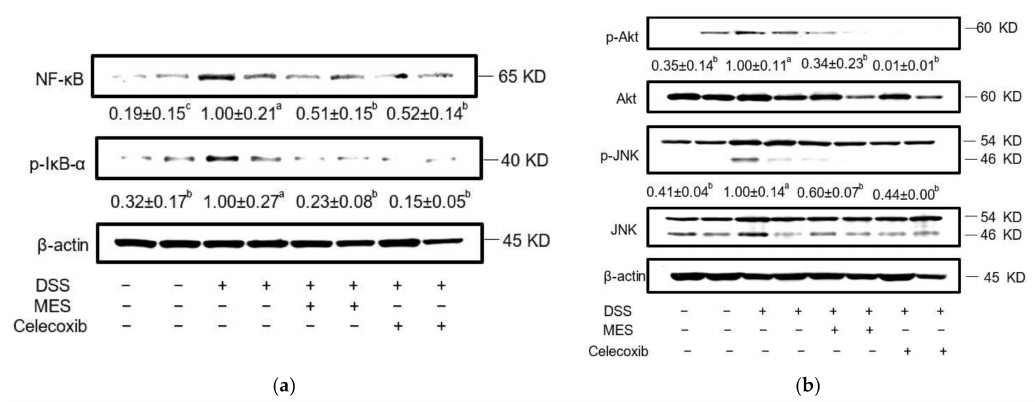
Figure 6. MES administration inhibits NF- κ B, Akt and JNK signal pathways in DSS-induced colon tissues. Protein levels of ( a ) NF- κ B, p-I κ B α , ( b ) p-Akt, Akt, p-JNK, and JNK were determined by Western Blot. All data are expressed as mean ± SD. Bars with no common letters are significantly different ( p < 0.05). DSS: dextran sulfate sodium; MES: meroterpenoid-rich ethanoic extract of a brown algae, Sargassum macrocarpum ; NF- κ B, nuclear factor kappa-light-chain-enhancer of activated B cells; Akt, protein kinase B; JNK, Jun N-terminal